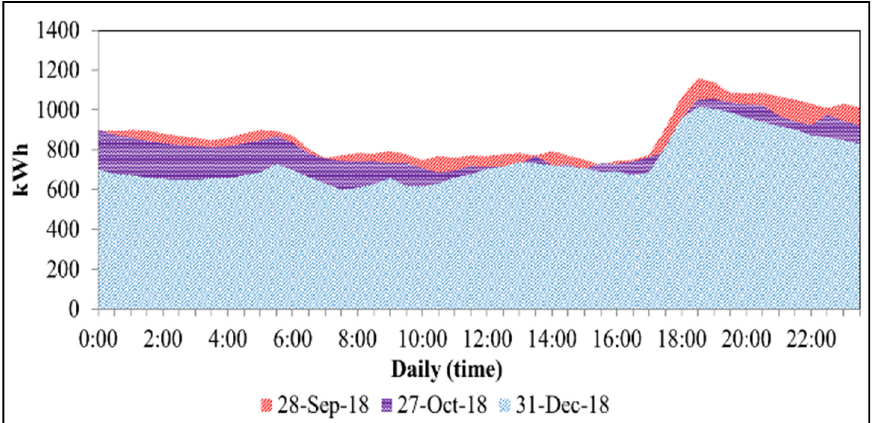
Figure 7. Daily power consumption.